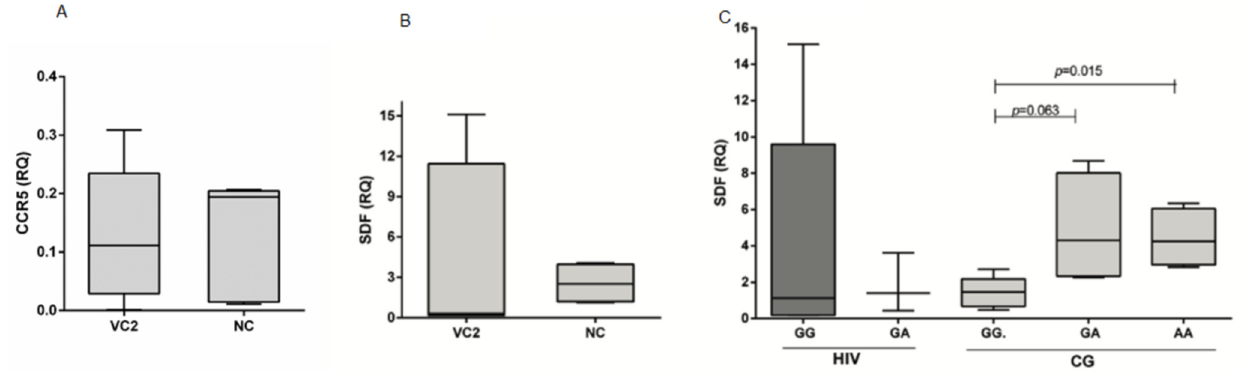
Figure 1. Levels of CCR5 mRNA ( A ) between viremia 2 controllers (VC2) and non-controllers (NC); ( B ) levels of SDF1 mRNA between VC2 and NC; and ( C ) according to the genotype of the SDF1-3 ′ A variant (rs1801157) in HIV-1 infected individuals and in the control group (CG). RQ: relative quantification.